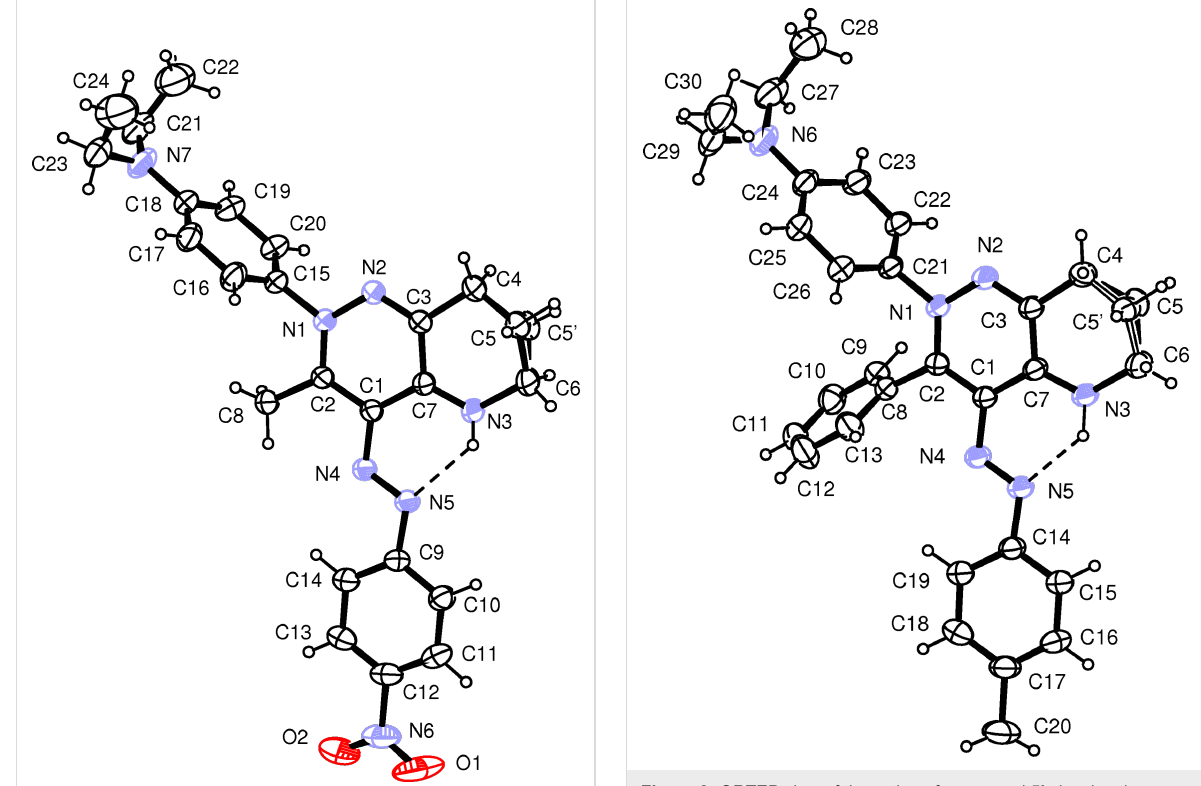
Figure 2: ORTEP view of the cation of compound 5l showing the thermal ellipsoids at 30% probability level. Both the disordered C5H 2 and C5’H 2 moieties are